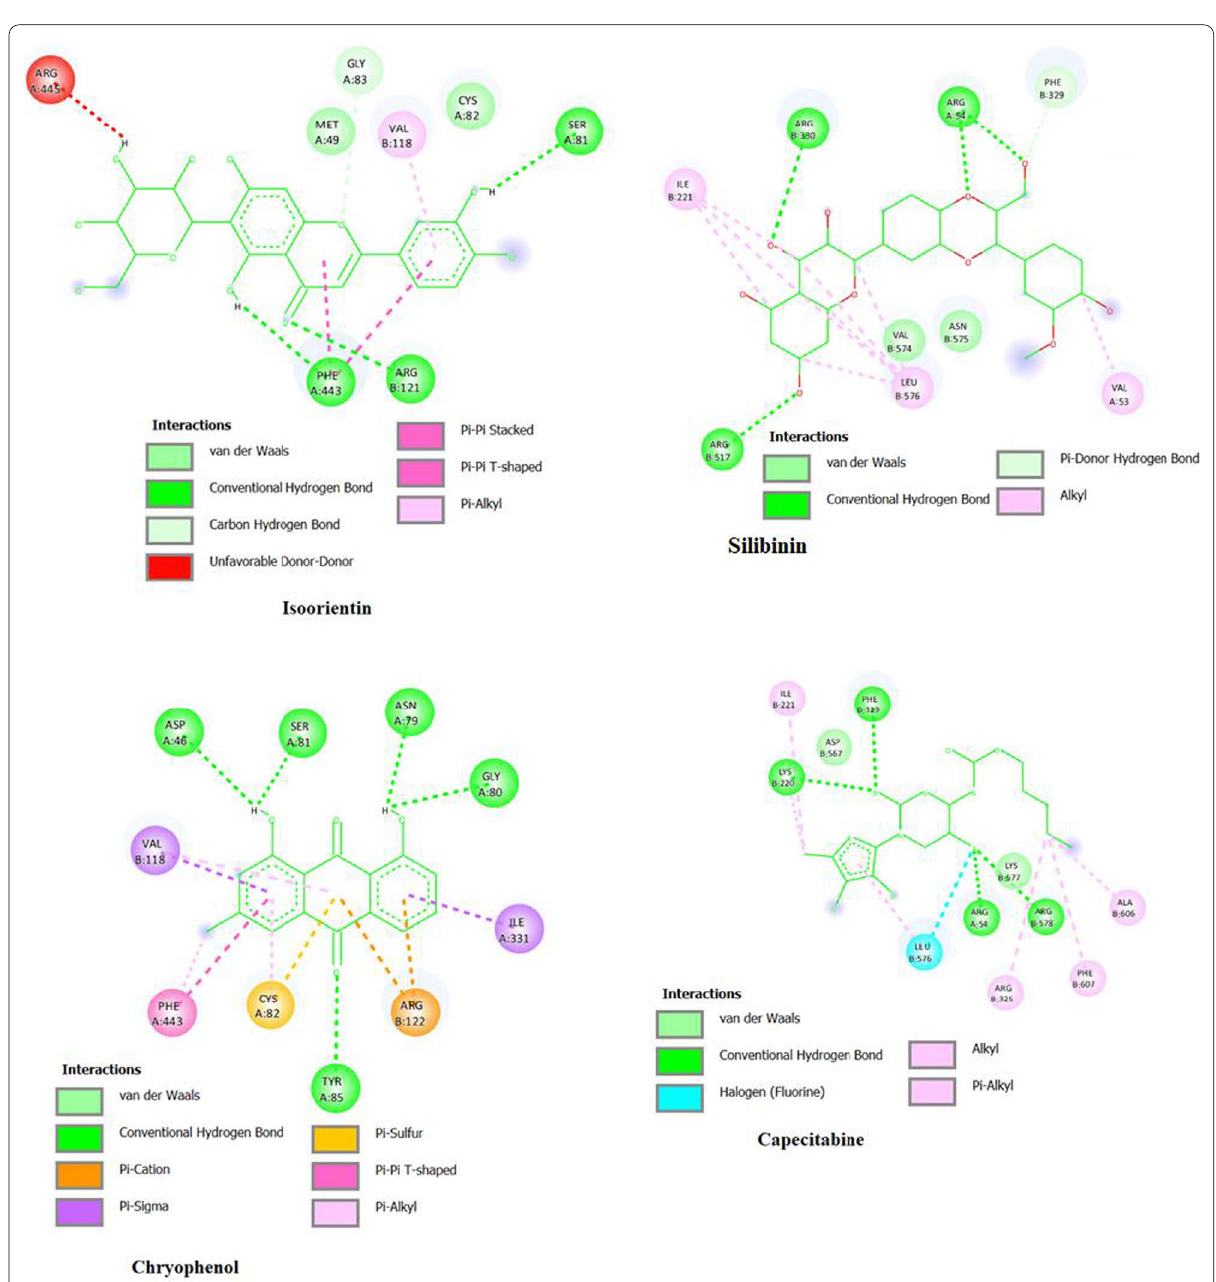
Fig. 3 Binding affinities of APC protein with phytochemical structure using AutoDock Vina. The 2D structure of protein–ligand interactions is visualized using a Discovery studio visualizer and the interactions are predicted based on binding energy (kcal/mol) and hydrogen